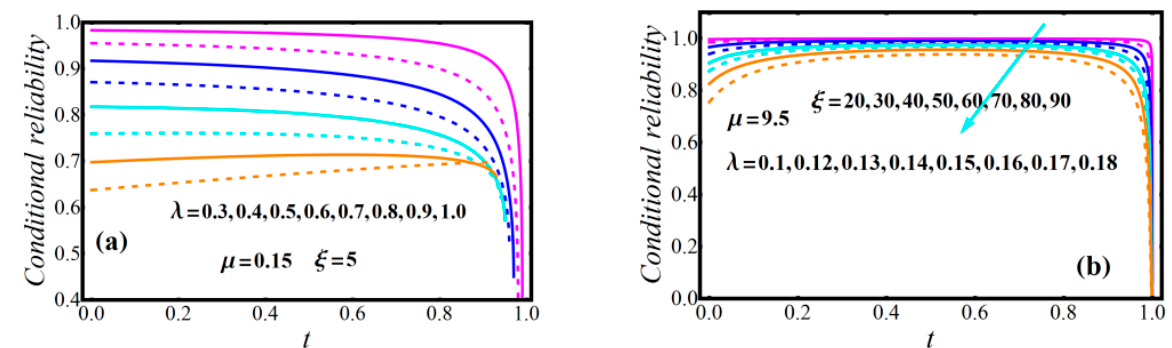
Figure 6. Plots of the conditional reliability of the NHPP–NPF model. Higher values (